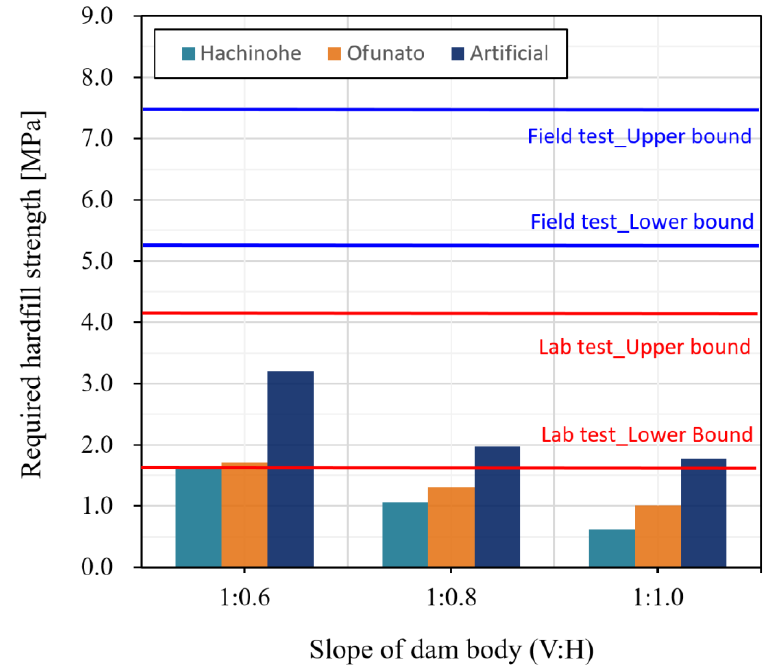
Figure 14. Results of FE analysis (required hardfill